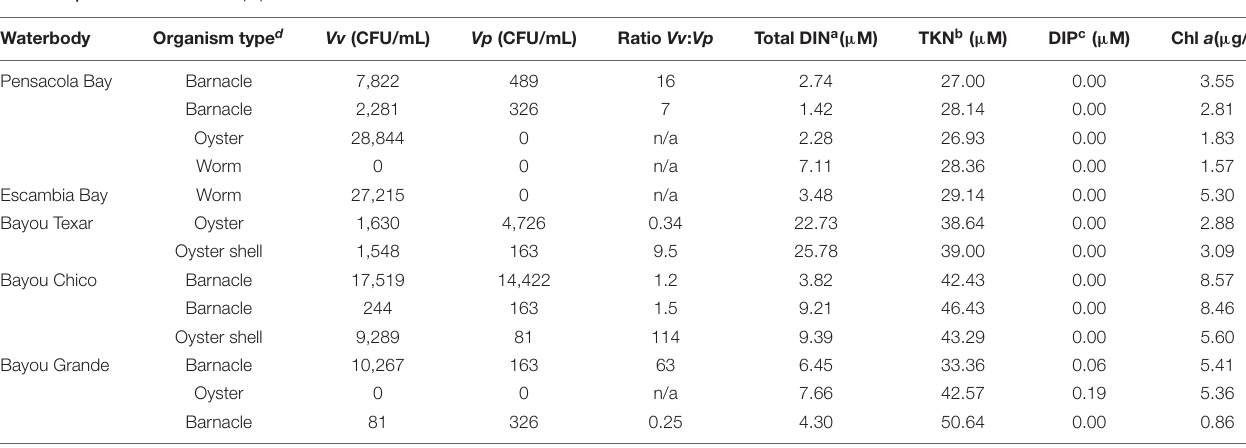
TABLE 4 | Numbers of Vv and Vp present in biofilms on